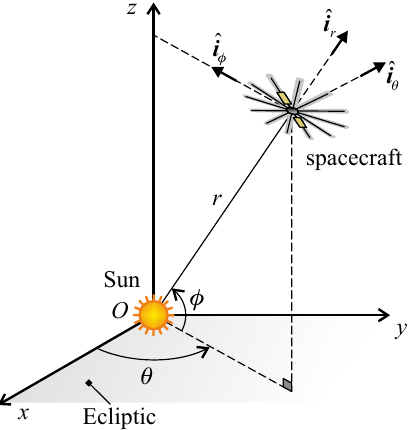
Figure 1. Reference frames and spacecraft state variables.